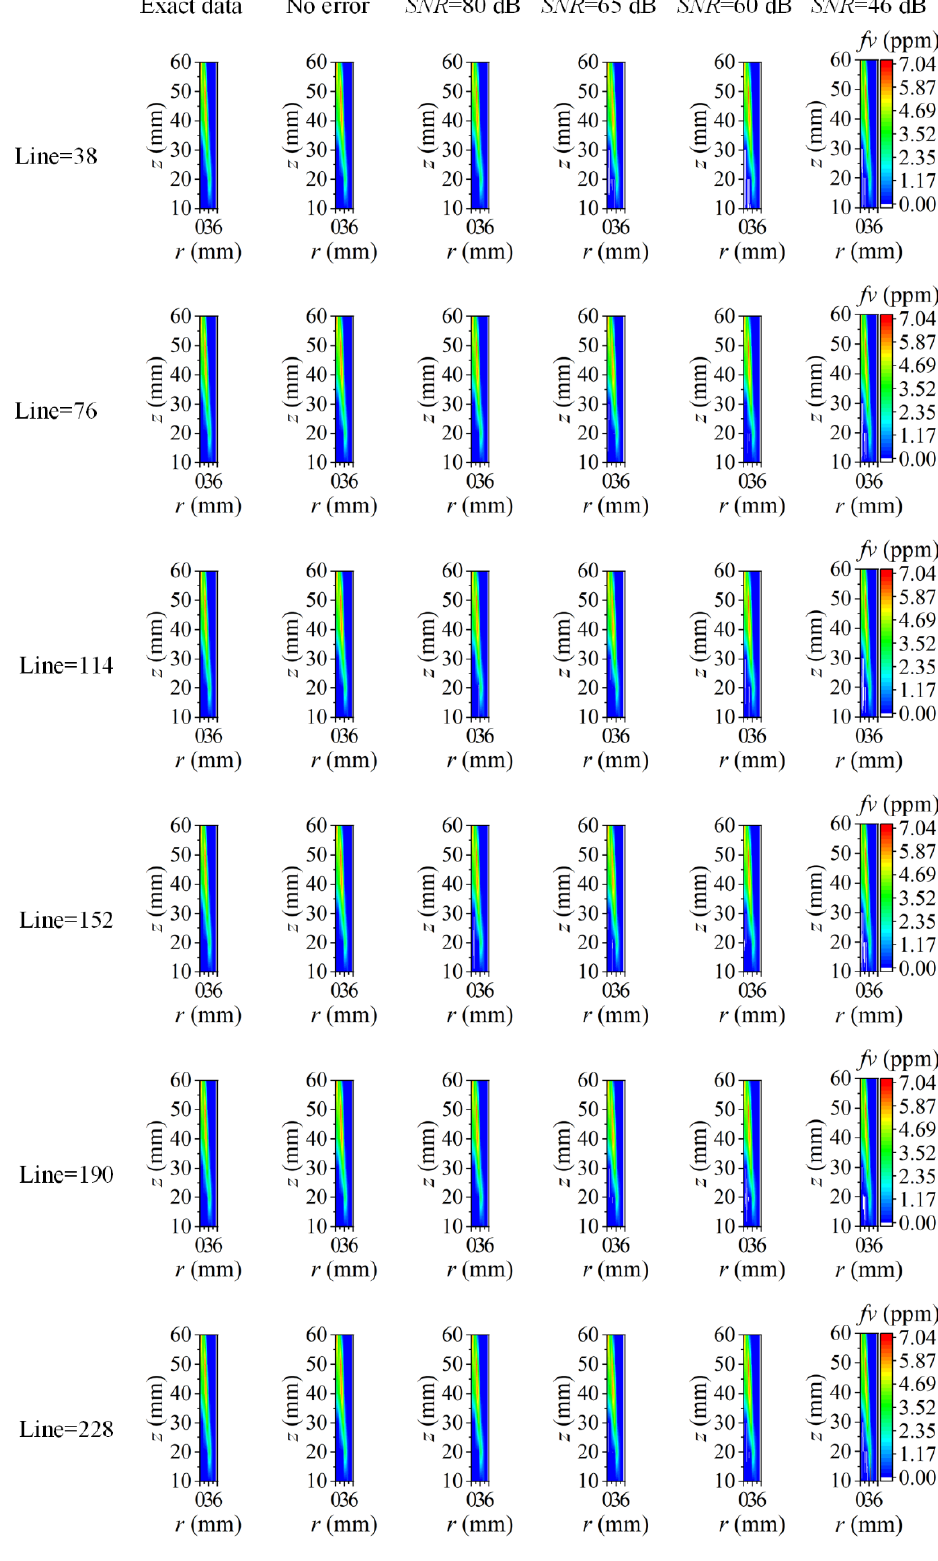
Figure 12. The two-dimensional distribution of reconstructed soot volume fraction under different ray numbers and different cases of SNR .